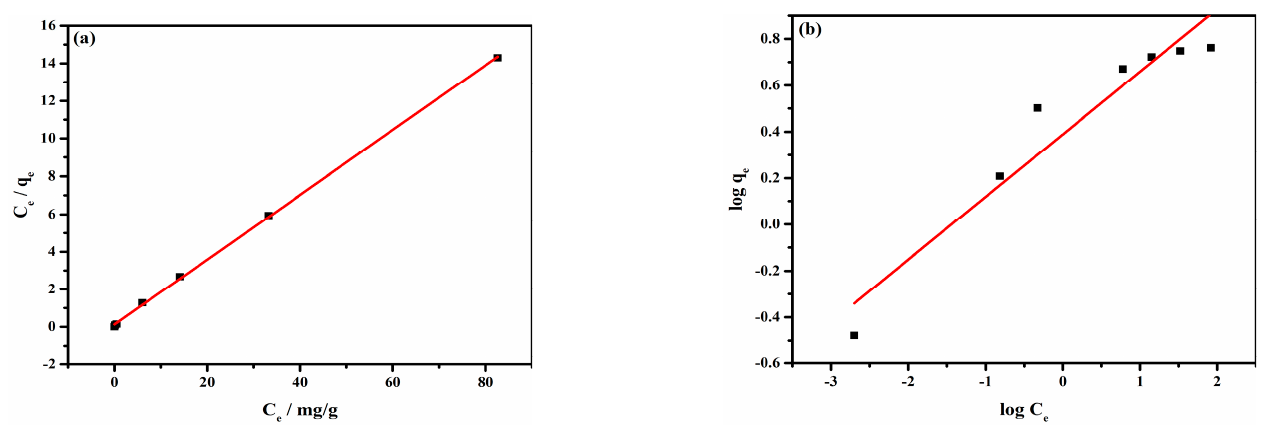
Figure 4. Langmuir ( a ) and Freundlich ( b ) isotherms for the adsorption of Cr(VI) onto the MnFe 2 O 4 adsorbent. Table 2. The parameters for Langmuir and Freundlich models for Cr(VI) adsorption onto the MnFe 2 O 4